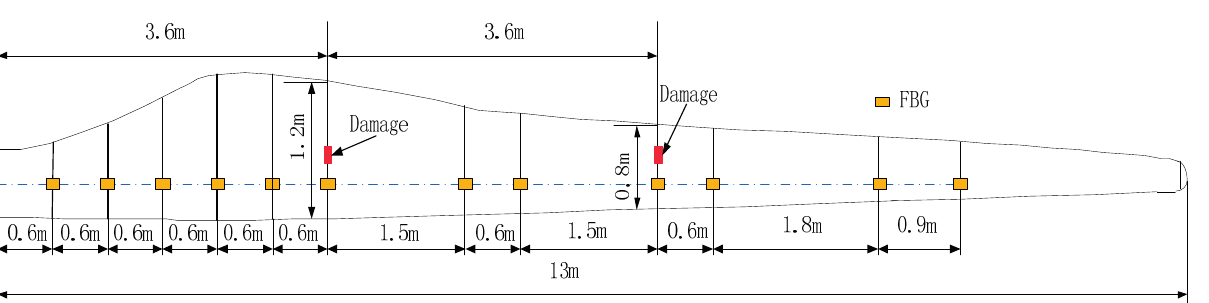
Figure 2. The schematic of the FBG and